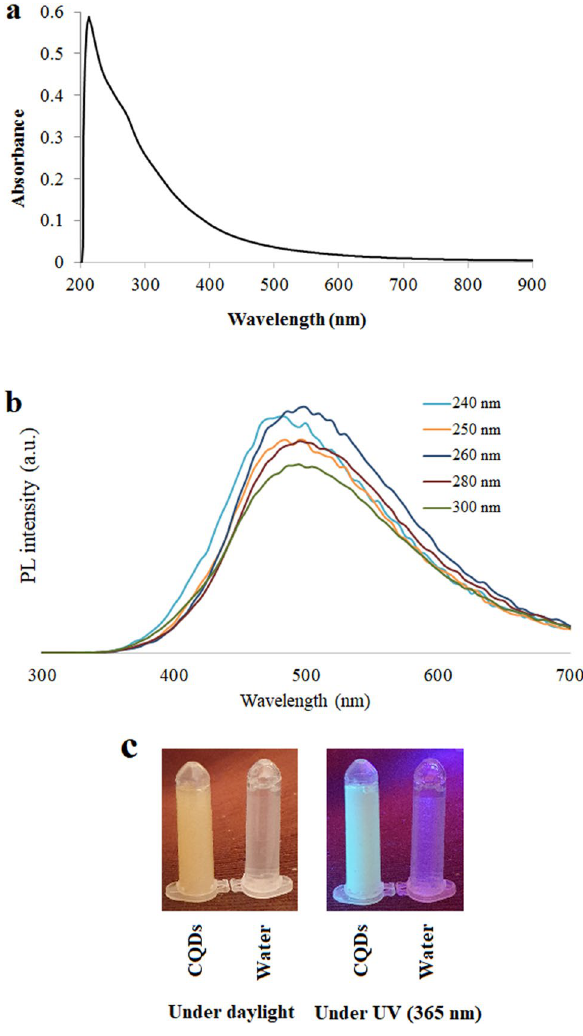
Figure 5. ( a ) The UV–Vis absorption spectrum of the CQDs solution with a concentration of 0.2 mg/mL. ( b ) PL spectroscopy spectra of the synthesized CQDs at different excitation wavelengths. ( c ) The CQDs in comparison with deionized water under UV and visible